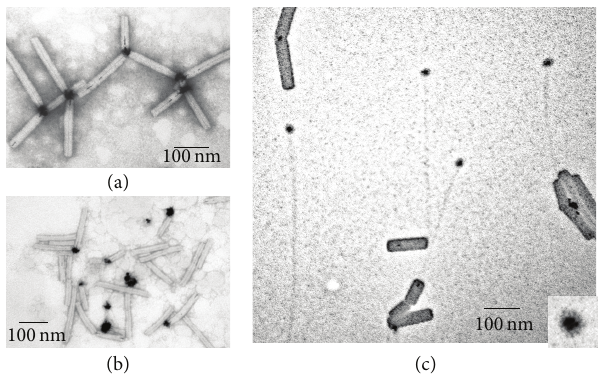
Figure 5: Platinum modification of the ultrasonically treated TMV.